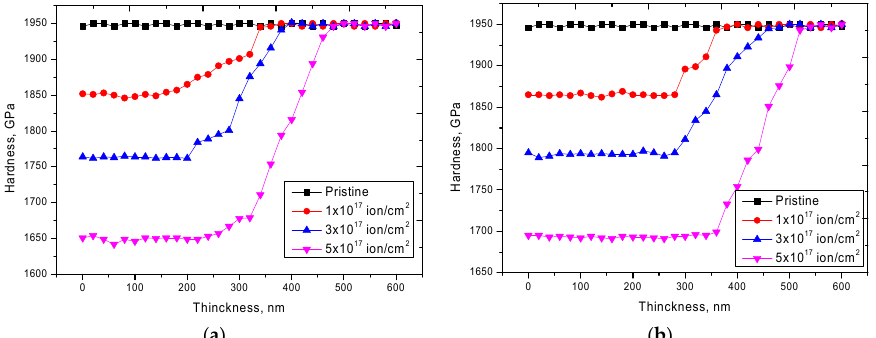
Figure 5. Dynamics of microhardness changes by depth depending on the irradiation conditions. ( a ) 300 K, ( b ) 1000 K.